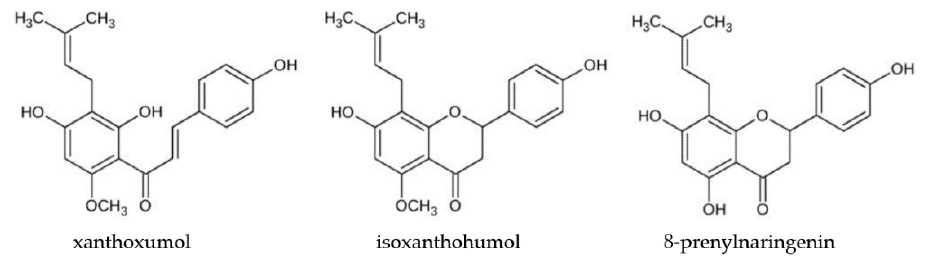
Figure 9. Structure of xanthohumol, isoxanthohumol and 8-prenylnaringenin [163].